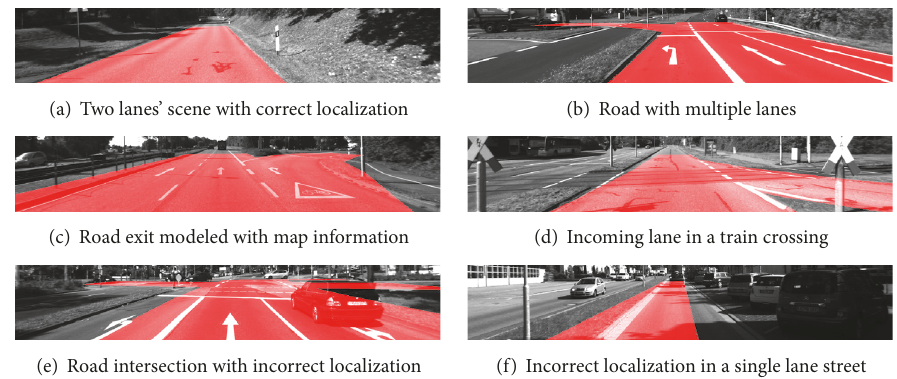
Figure 14: Road models estimated from the road shape information extracted from the map.